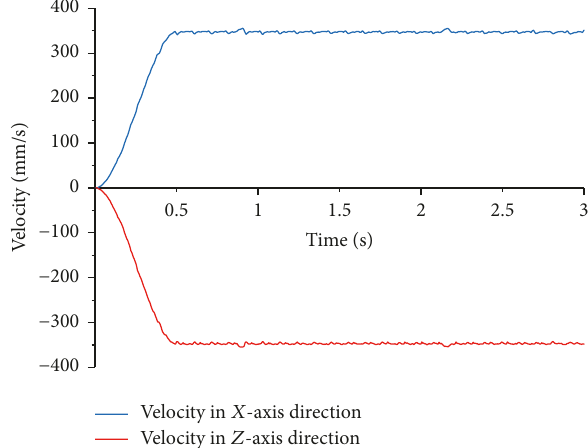
Figure 10: Velocity-time curves in 𝑋 -axis and 𝑍 -axis direction in oblique motion at 45 ∘